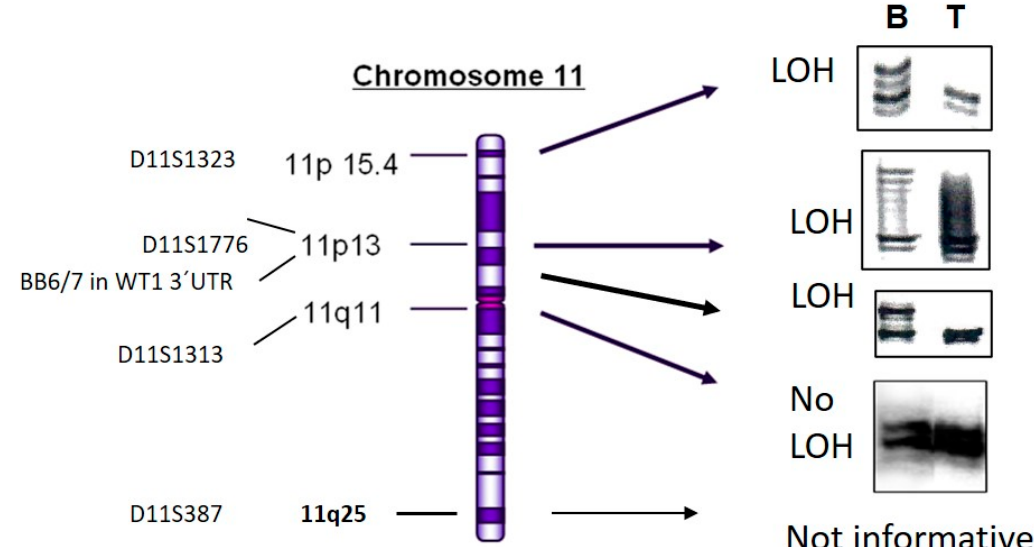
Figure 1. LOH analysis of DNA from patient Wilms5. DNA from tumor cell culture (T) and blood (B) of patient Wilms5 was analyzed with the indicated markers from chromosome 11. The IRD800 labeled PCR products were separated on 6% polyacrylamide gels. All markers from 11p15 to the 3´UTR of WT1 show loss and the first marker more proximal in 11q11 shows no LOH. The marker from 11q25 was not informative.